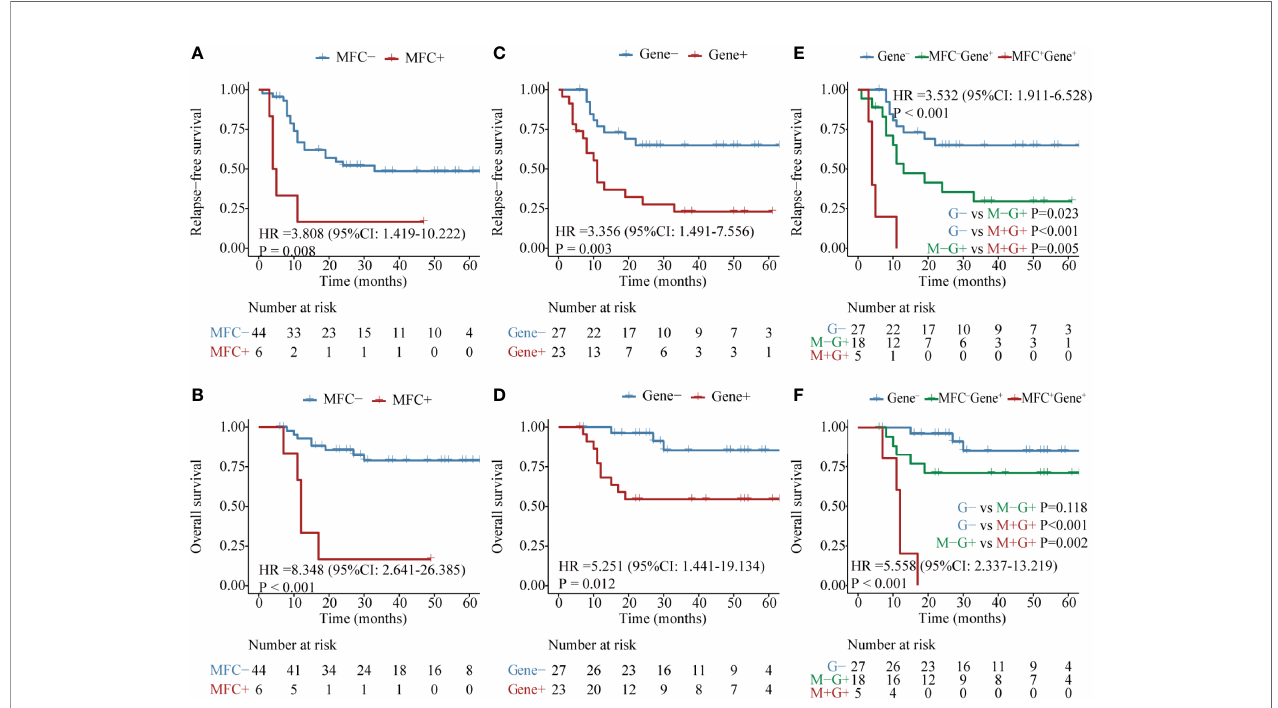
FIGURE 2 | Kaplan – Meier curves for probability of relapse-free survival (RFS) and overall survival (OS) in AML patients with RUNX1 – RUNX1T1 fusion gene. (A, B) RFS and OS based on MFC MRD status post two cycles of consolidation. (C, D) RFS and OS based on the quanti fi cation of RUNX1 – RUNX1T1 transcript levels post two cycles of consolidation. (E, F) RFS and OS based on the integration of the two MRD monitoring methods.